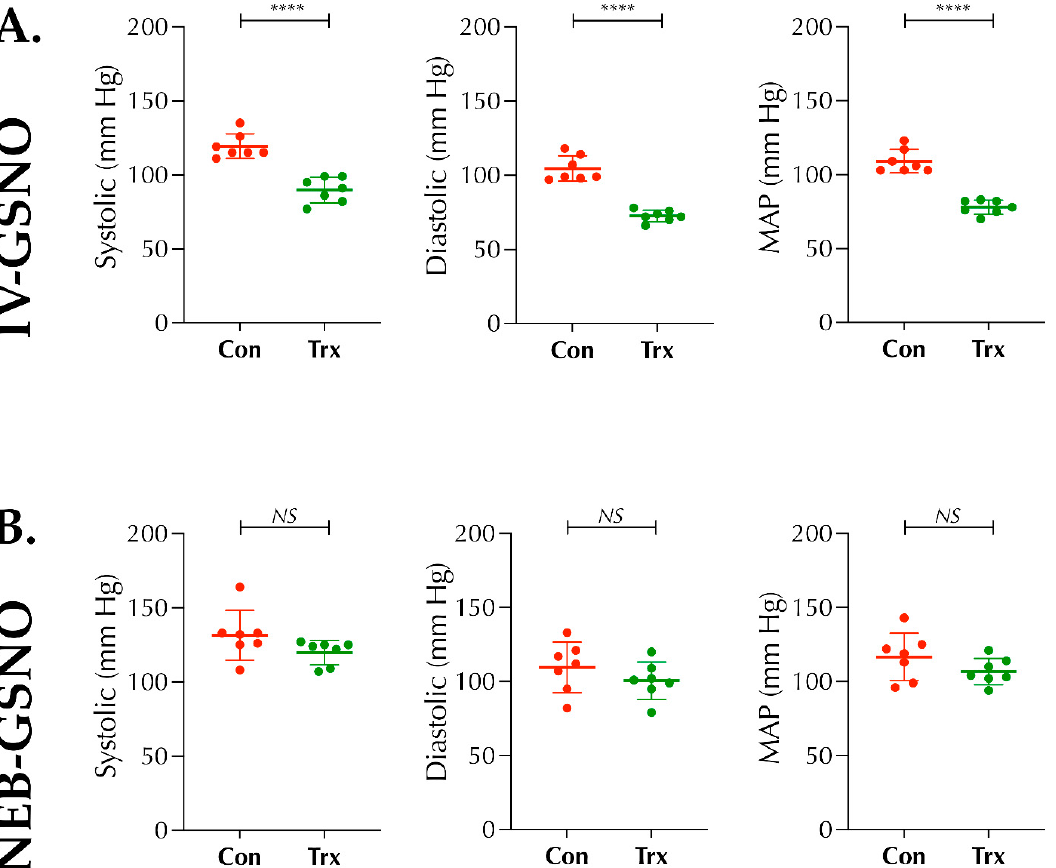
Figure 1. Effect of the route of administration of exogenous s-nitrosoglutathione (GSNO) on blood pressure (BP): Diabetic male mice (C57/B6 background, 14 ± 1-wks. old) were acclimatized with the tail-cuff instrument and subjected to BP- measurements with or without Veh/IV-GSNO or Veh/GSNO-Nebulization. BP-measurement was performed 20 min later. ( A ) Significant effect of IV-GSNO treatment (1 mg/kgbwt) was found on BP-lowering compared to their baseline control (****, p = 0.0001), and ( B ) No significant (NS) alteration was found with GSNO-nebulization (200 µ g/kgbwt) compared to their baseline control (NS; p = 0.174 for Mean Arterial Pressure, MAP). Data are presented as Mean ± SD ( n = 7 mice/group). Statistical significance was determined at p < 0.05 and using a paired t-test